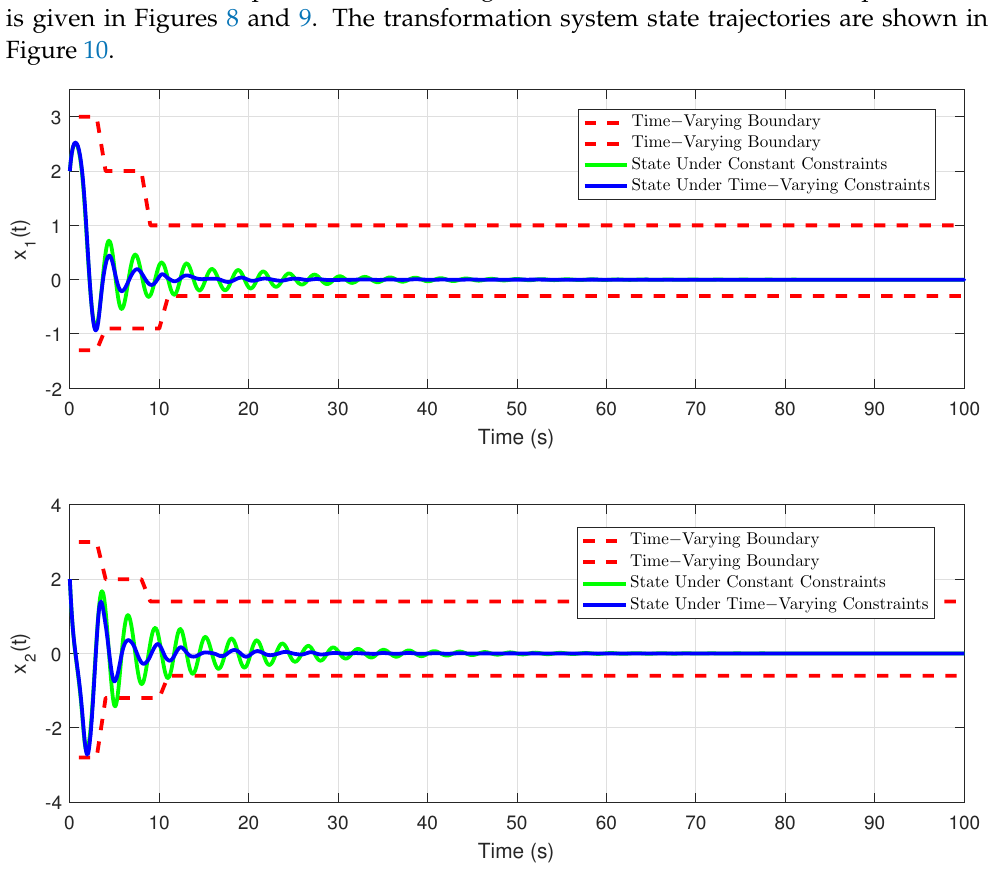
Figure 6. Evolution of the state x ( t ) by using the presented method and the method in